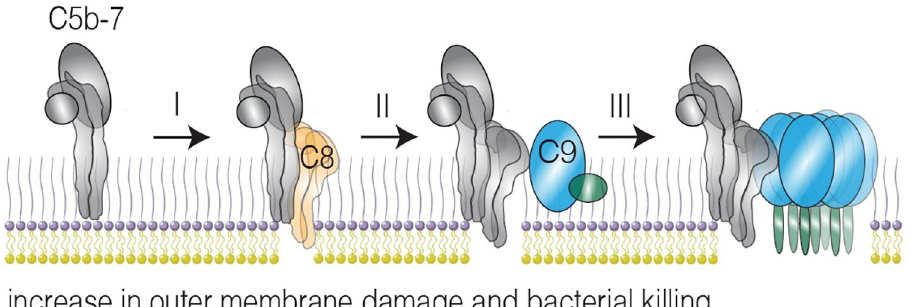
Fig 7. Assembly of MAC pores enhances OM damage and bacterial killing. Schematic overview how MAC pores assemble on E . coli and their effect on outer membrane damage and bacterial killing. I) C8 (orange) binds to membrane-anchored C5b-7 (grey) and subsequently inserts transmembrane β -hairpins into the bacterial outer membrane (OM), which causes small lesions in the OM. II) Binding of C9 (blue) to C5b-8 without polymerization of C9 slightly increases the OM damage and bacterial killing. III) C9 polymerizes and forms a transmembrane polymer, which drastically increases OM damage and rapidly kills